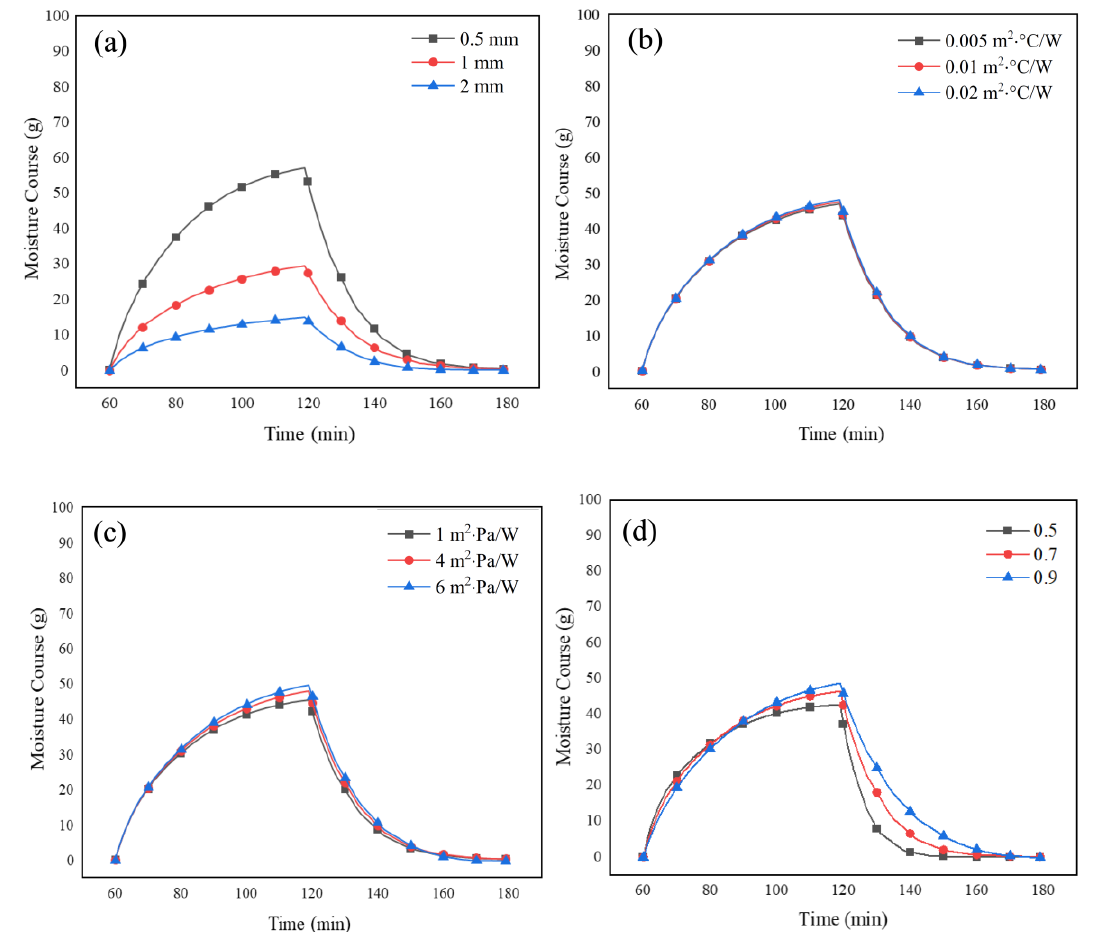
Figure 6. The effect of ( a ) fabric thickness, ( b ) thermal resistance ( c ) evaporative resistance, and ( d ) fabric porosity on moisture course measurement obtained from the numerical model.